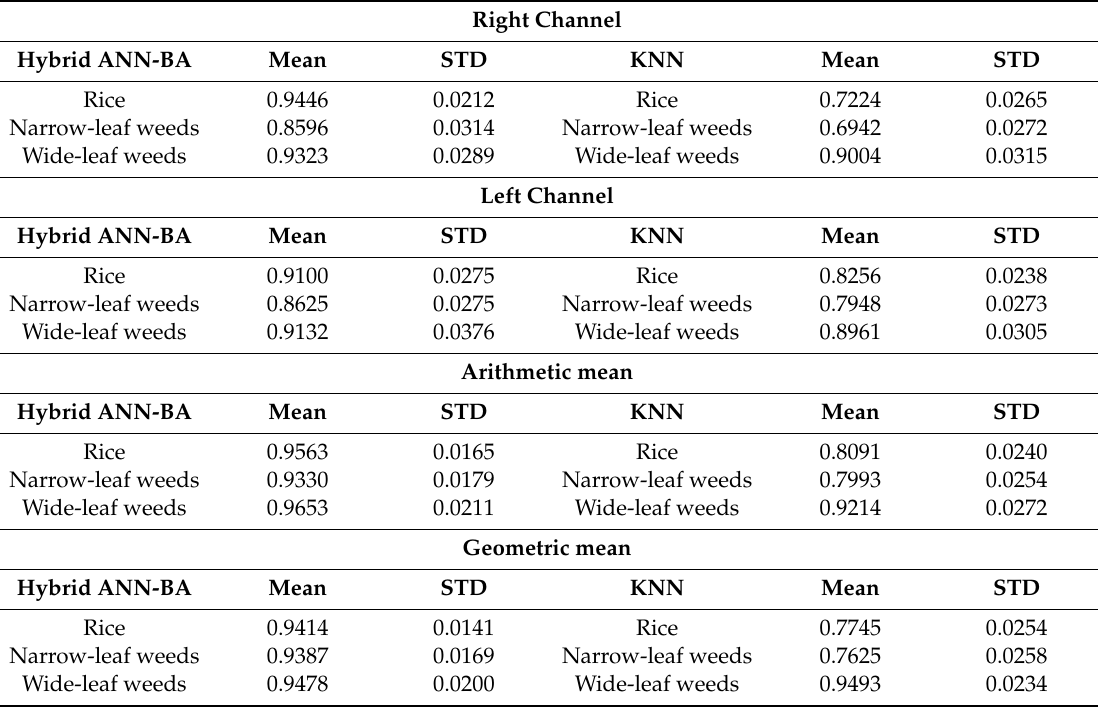
Table 7. Mean and standard deviation (STD) values of accuracy for the proposed hybrid ANN-BA and the KNN classifiers: three classes and four classifier